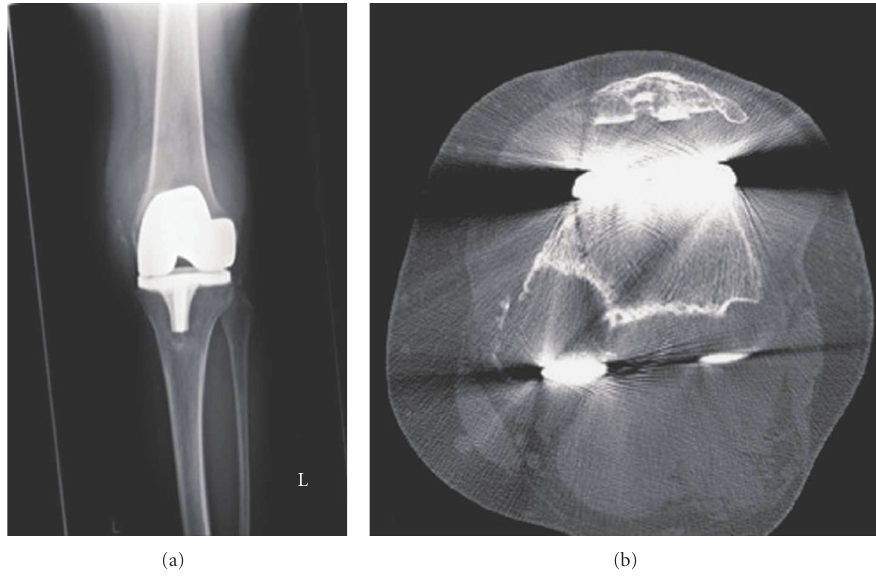
Figure 1: AP radiograph showing a knee with severe polyethylene wear and evidence of major bone loss (a). A CT scan showing massive bone loss of the medial and lateral femoral condyles due to osteolysis (b). (reprinted from Backstein et al. [2]).